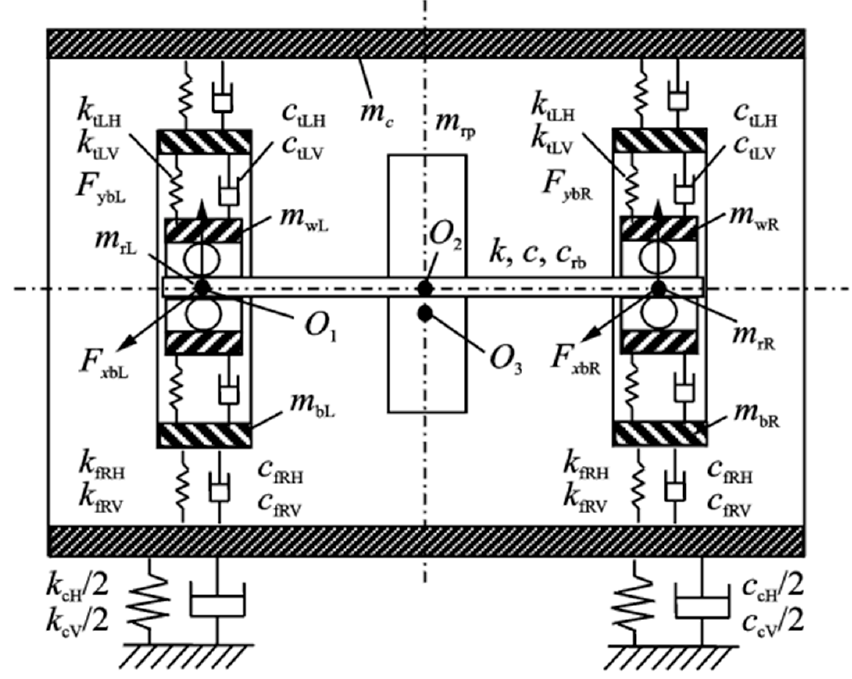
Figure 1. Diagrammatically representing the simulated rotor-bearing system.